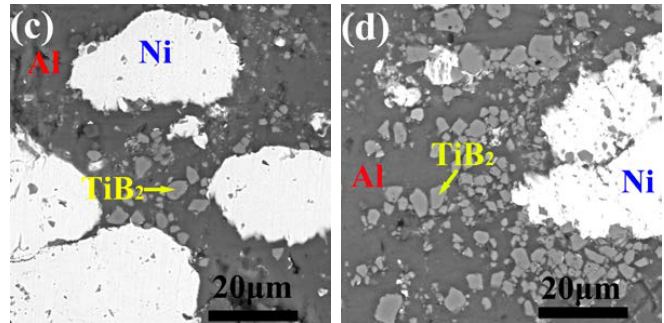
Figure 4. Cross-sectional morphologies of the cold-sprayed Ni/Al-TiB 2 coatings at ( a , c ) 250 °C and ( b , d ) 450 °C.